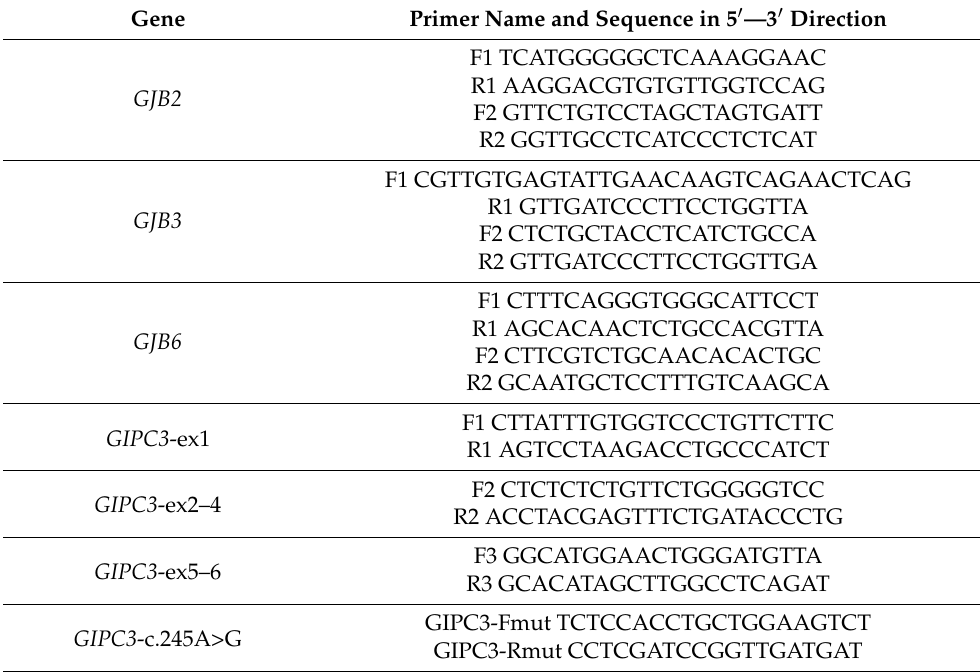
Table 2. Primers used in the study.